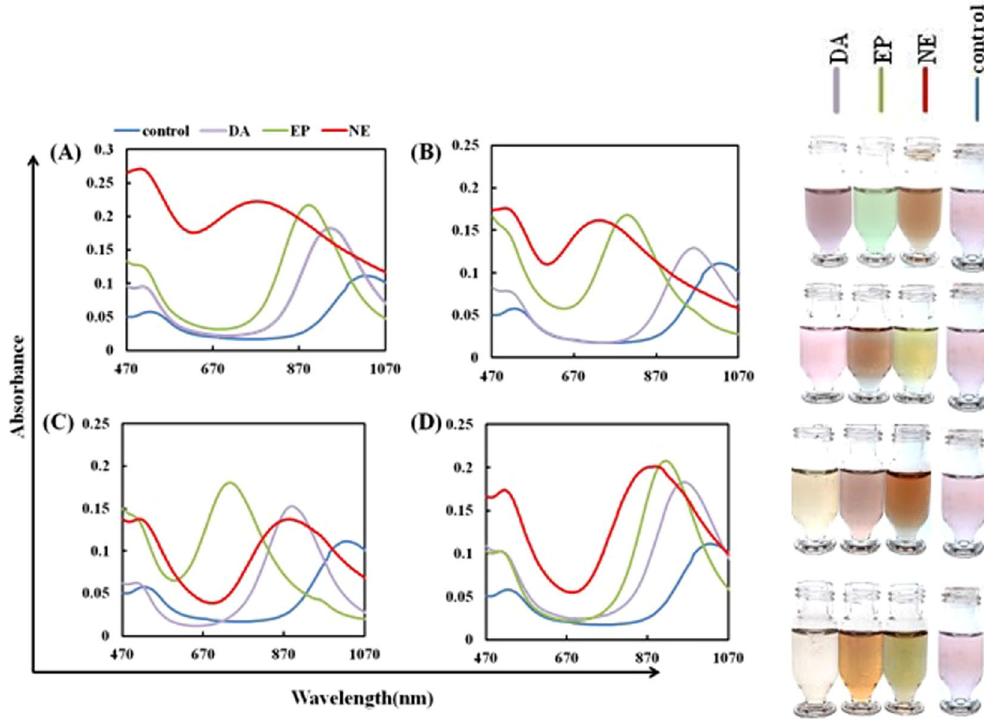
Figure 2. UV-visible spectra and corresponding images of ( A ) SE1, ( B ) SE2, ( C ) SE3 and ( D ) SE4: before and after addition of dopamine, epinephrine and norepinephrine (catecholamine at concentration of 20 µ g mL − 1